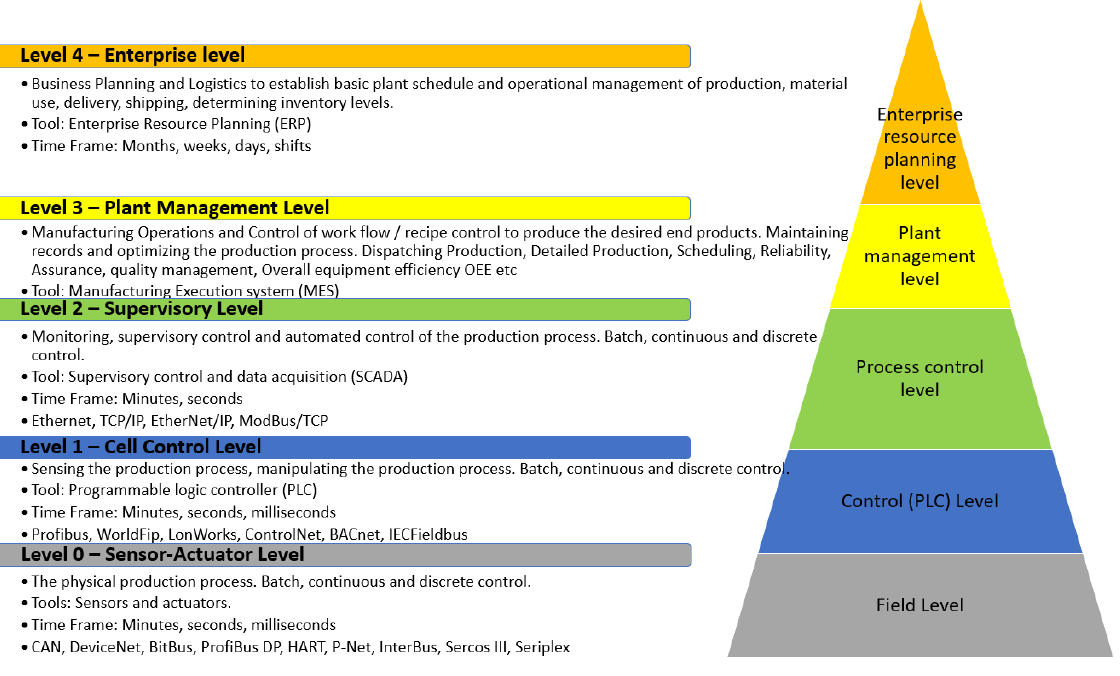
Figure 10. Traditional layered architecture based on ISA 95 model.